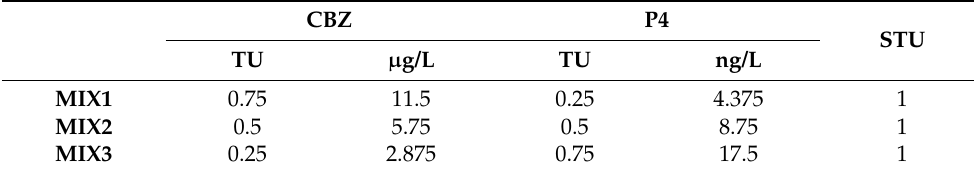
Table 1. Composition of mixtures